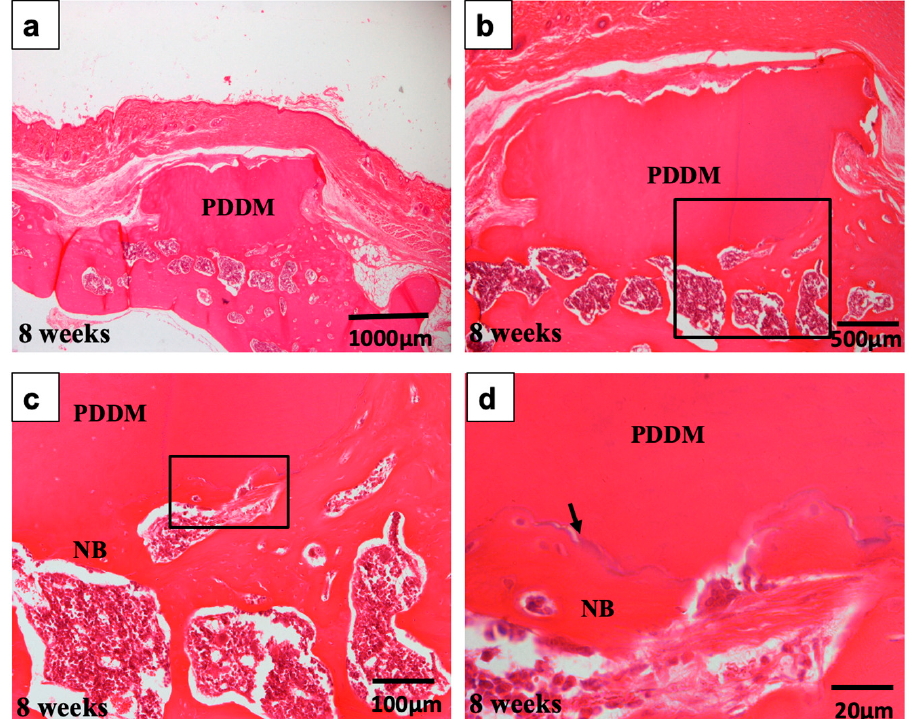
Figure 9. Histological images of scratched skull without periosteum at 8 weeks. ( a ) Acellular PDDM block connected with skull. Absorption of upper and lateral sides of block. ( b ) New bone formation widely between PDDM and skull. ( c ) Higher magnification of frame in ( b ). New bone with red marrow. ( d ) Higher magnification of frame in ( c ). PDDM divided from new bone by the presence of a linear cementum line (arrow). PDDM: Partially demineralized dentin matrix.